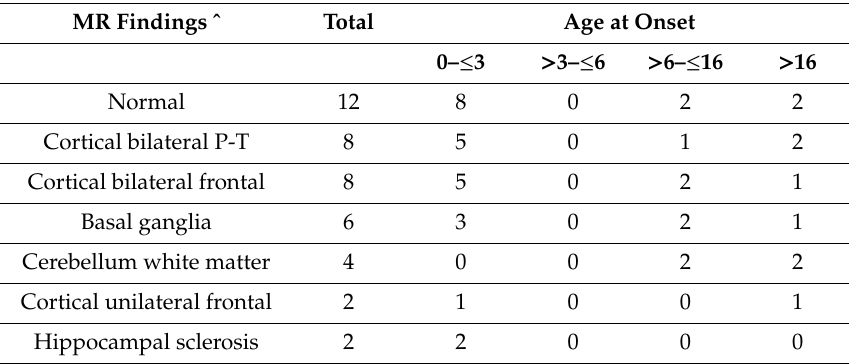
Table 3. Cont. Neuroimaging Findings by Age at